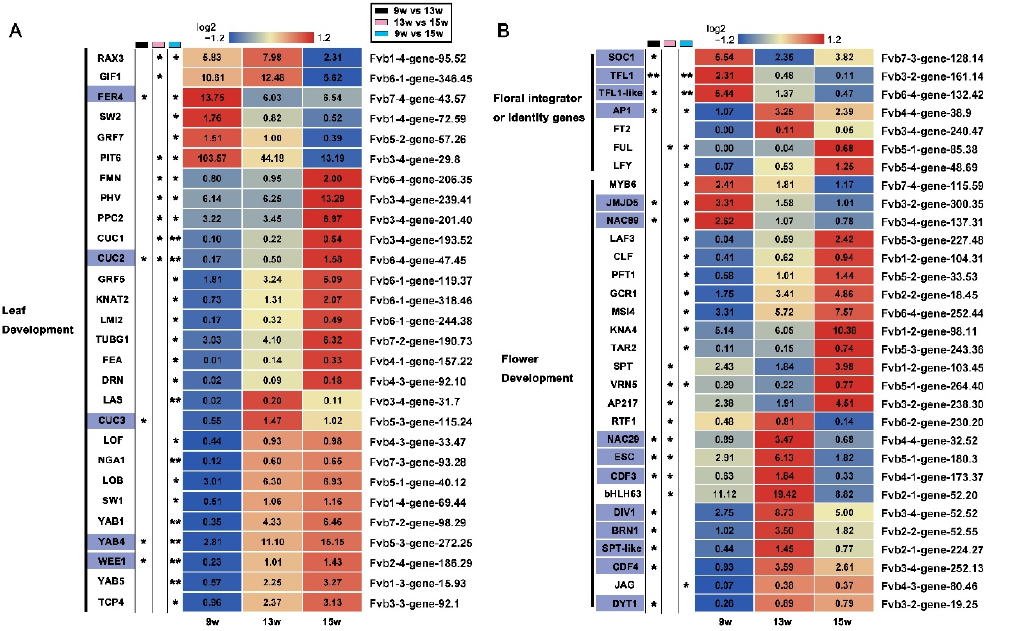
Figure 4. FPKM values of DEGs related to leaf and flower development. ( A ) Heat map showing the DEGs that may be involved in leaf development. ( B ) Heat map showing the DEGs that may be involved in flower development. The purple boxes indicate the genes in which expression was significantly changed at 13 w. 9 w: vegetative stage, 13 w: shifts to reproductive stage at gene level, 15 w: reproductive stage. The column with the black boxes represents the student’s t test analysis of DEGs at 9 w vs. 13 w; The column with the pink boxes represents the student’s t test analysis of DEGs at 13 w vs. 15 w; The column with the blue boxes represents the student’s t test analysis of DEGs at 9 w vs. 15 w. (* |Log2FC| ≥ 1, p < 0.05. ** |Log2FC| ≥ 2, p < 0.01).